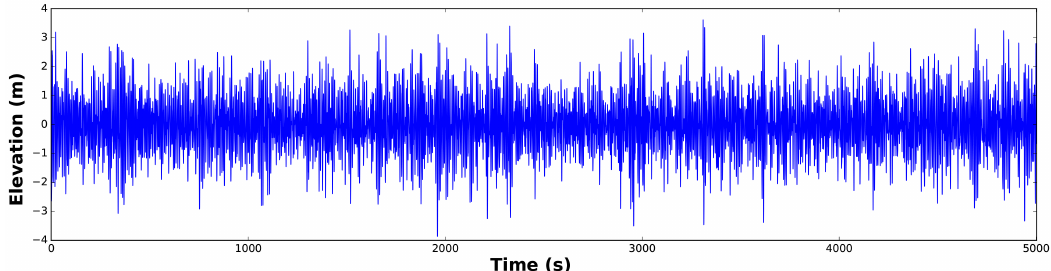
Figure 5. Time history of the simulated random waves, equal for each simulation. The represented water levels do not take into account the onshore water depth h = 12 m.